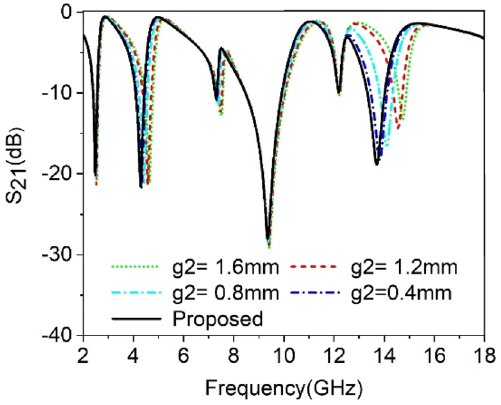
Figure 7. The transmission coefficient of the proposed unit cell for split gap variation, g2.